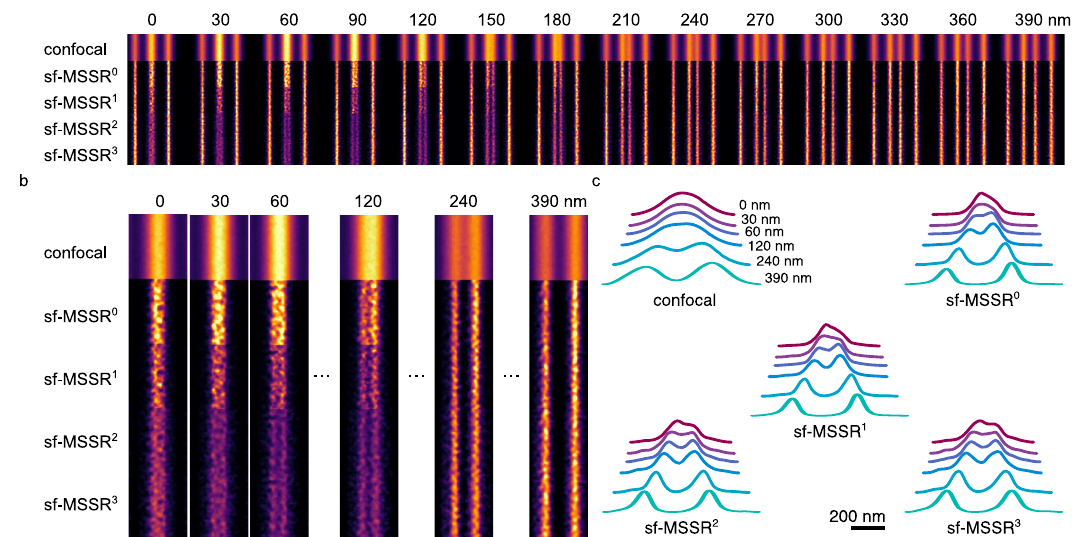
Fig. 3 | sf-MSSR n extends spatial resolution in confocal microscopy.